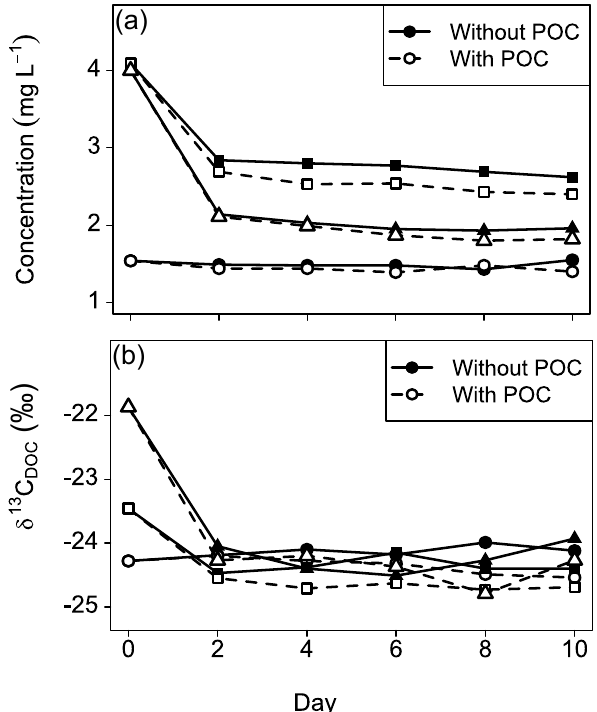
Figure 2. Comparison of evolution of (a) DOC concentration and (b) stable carbon isotope ratio of DOC ( δ 13 C DOC ) over time, for incubations with POC (unfiltered) and without POC (filtered). The three incubation series (Garissa 15 May 2013 (circles), Garsen 14 May 2013 (squares) and Garsen 26 May 2013; triangles) are rep- resentative of the eight data series, as they give an example of the low, medium and high response of the DOC. No consistent differ- ence was found between the different sampling sites. The full data set for all incubations can be found in the